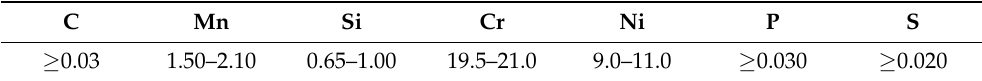
Table 1. Chemical composition (wt.%) of the 308LSi wire according to EN ISO